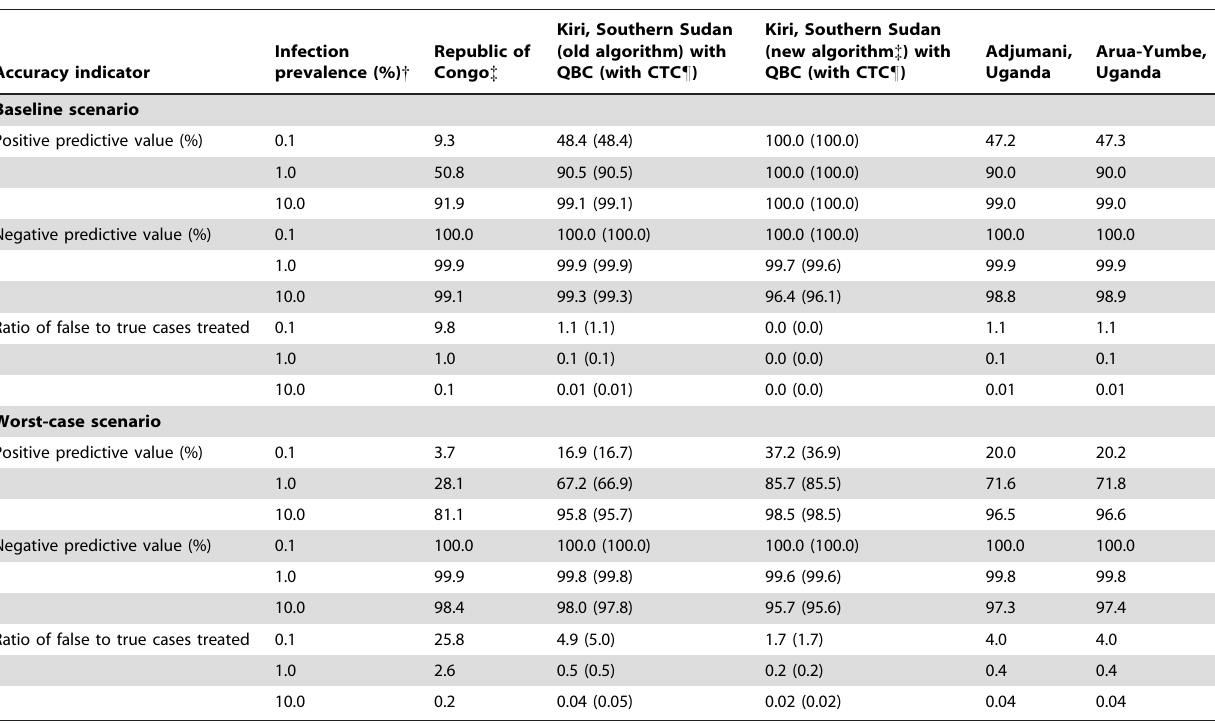
Table 6. Predictive values and over-treatment ratio for each algorithm, at three different prevalence levels.